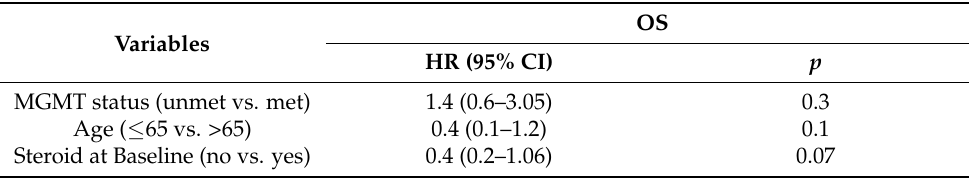
Table 3. Multivariate analysis for overall